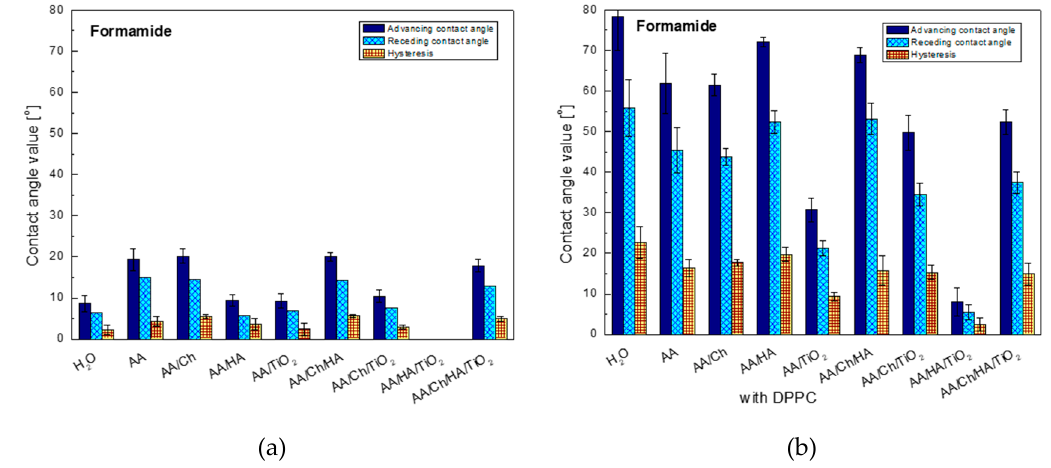
Figure 2. Advancing and receding contact angles of formamide (F) and its hysteresis on the activated glass plates after the contact with the subphase in the absence of DPPC ( a ) and in the presence of DPPC ( b ). Analysis of wettability of the glass plate surface (with the deposited DPPC layer, transferred from different subphases) using formamide shows a significant increase in the contact angles for all tested systems, with the highest increase (9-fold) for the DPPC monolayer transferred from H 2 O and